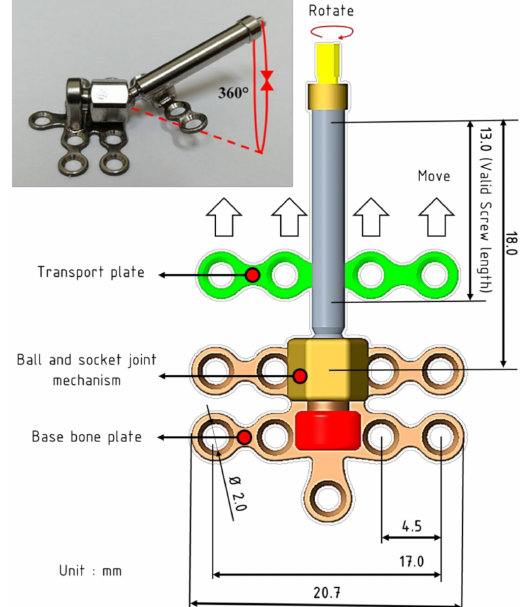
Figure 1. The new developed multi-axial alveolar distractor consists of an extra-osseous system with a ball and socket joint mechanism wielded to a base bone plate, transport plate and activating transport screw. The upper left part shows the physically manufactured distractor made of Ti6Al4V